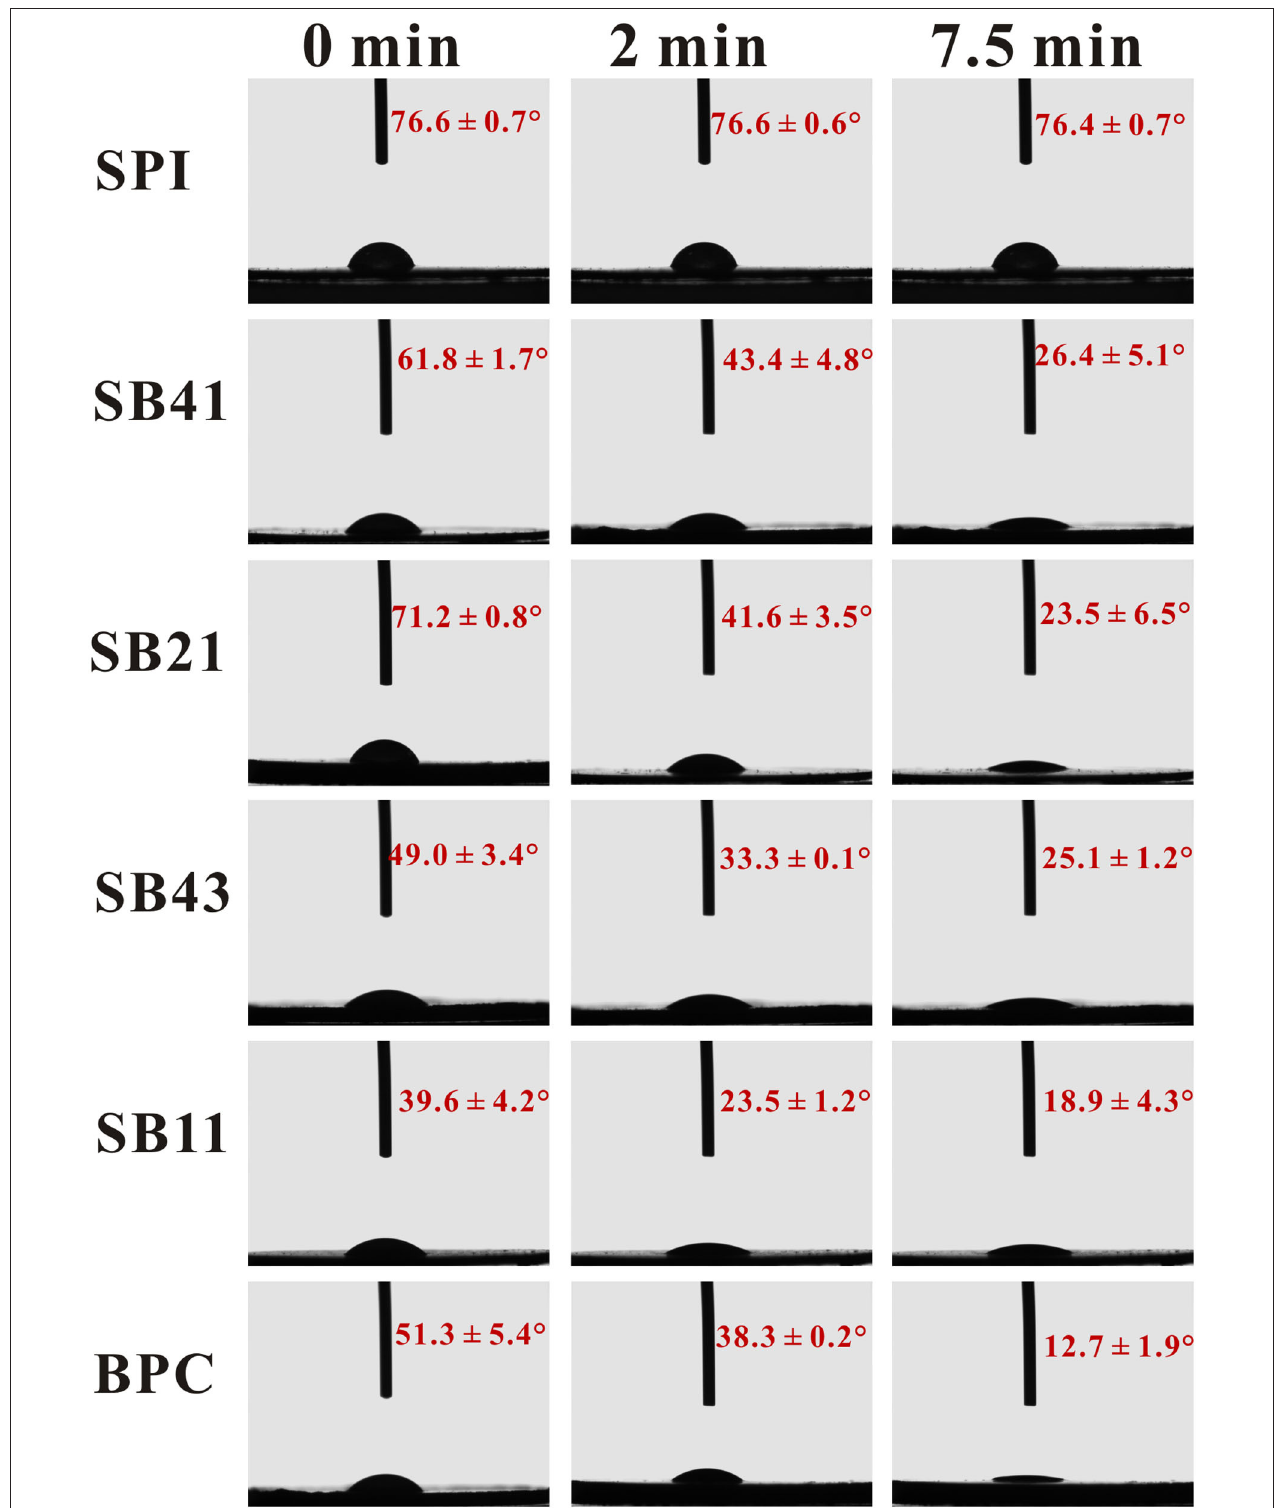
FIGURE 1 | The three-phase contact angle of SPI, BPC, and SPI/BPC colloidal particles with different ratios (4:1, 2:1, 4:3, 1:1).